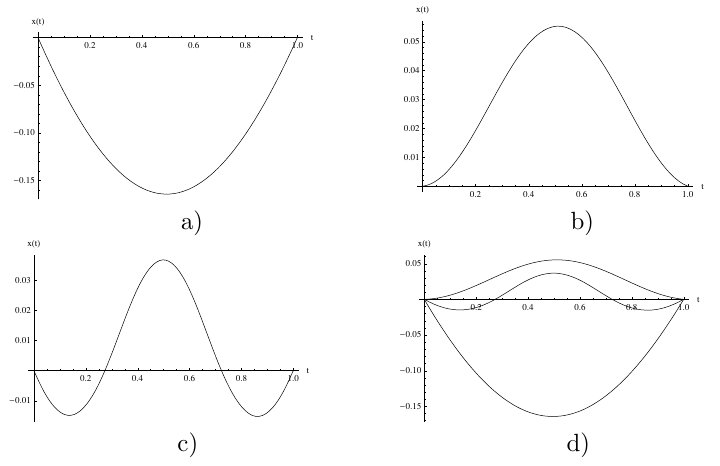
Figure 5. Solutions of BVP (1.1) where f and h are as in Example: a) ( λ,μ ) = (4 , 2) ∈ D 0 , x (cid:3) (0) = − 0 . 627431; b) ( λ,μ ) = (30 , 15) ∈ D 1 , x (cid:3) (0) = 0 . 0103358;